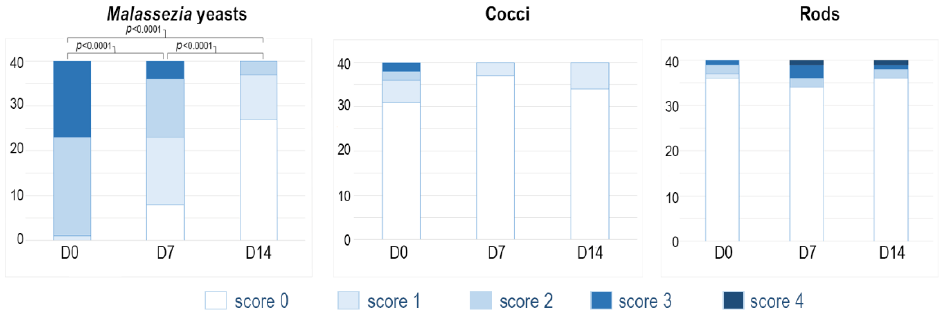
Figure 2. Stacked bar chart of the cytology score according to the type of microbe (yeasts, coccoid bacteria and rod-shaped bacteria) on Days 0, 7 and 14. The different intensities of colour in each bar show the number of ear canals with the different scores.